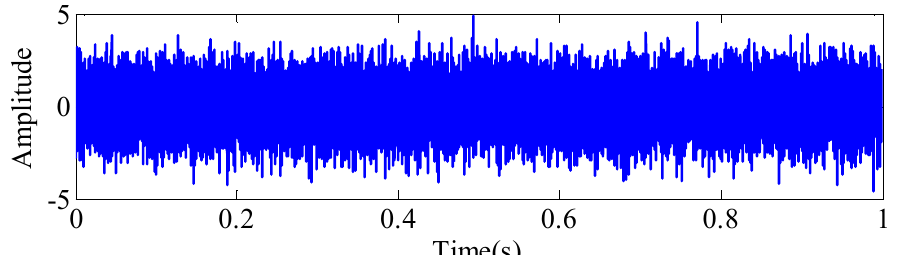
Figure 14. Time domain diagram of the selected signal segments of this algorithm.